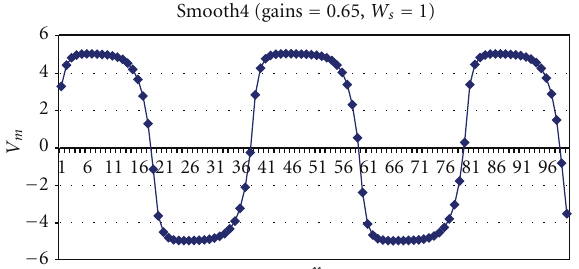
Figure 9: Output of the smooth4 neural oscillator. Here, the waveform is continuous and nondiminishing. Notice the smooth transitions on both sides of the peaks and troughs of the waveform.